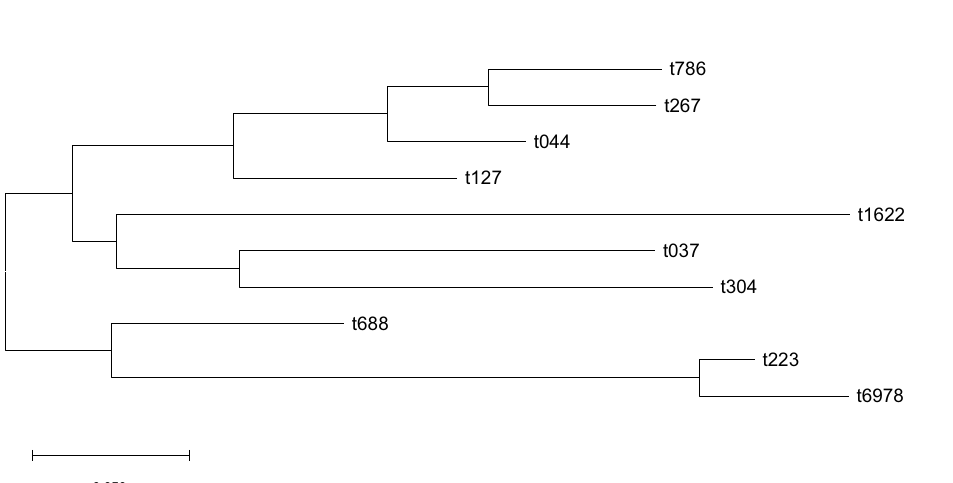
Figure 2. Phylogenetic tree of the spa types detected using the neighbour-joining method. The isolates were grouped in three clades, clade 1 containing isolates belonging to spa types t044, t267, t786 and t127, clade 2 containing isolates of spa t304, t037 and t1622 and clade 3 containing isolates from spa t688, t223 and